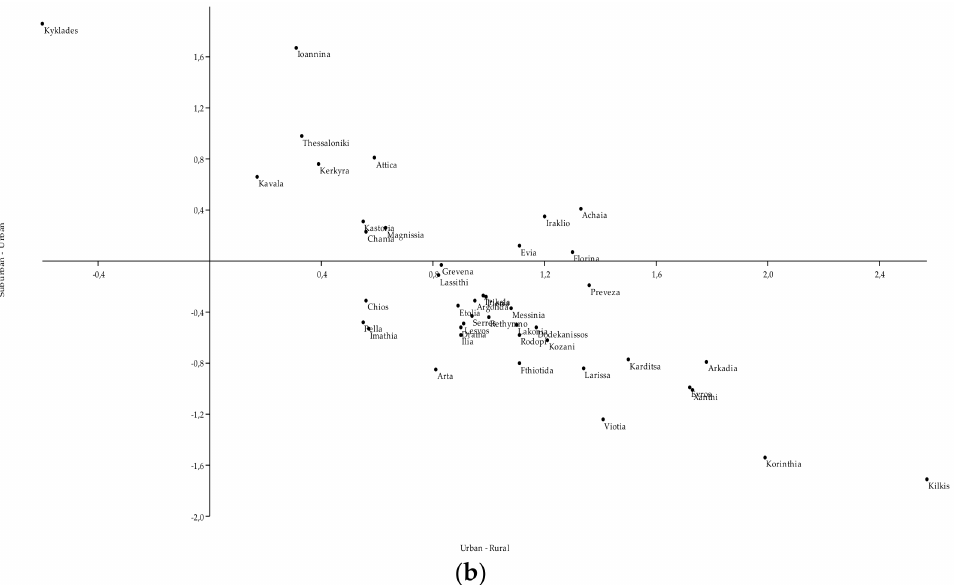
Figure 4. The relationship between fertility differentials in urban-to-rural districts and in suburban- to-urban districts for each Greek prefecture in ( a ) 2000–2009 and ( b )